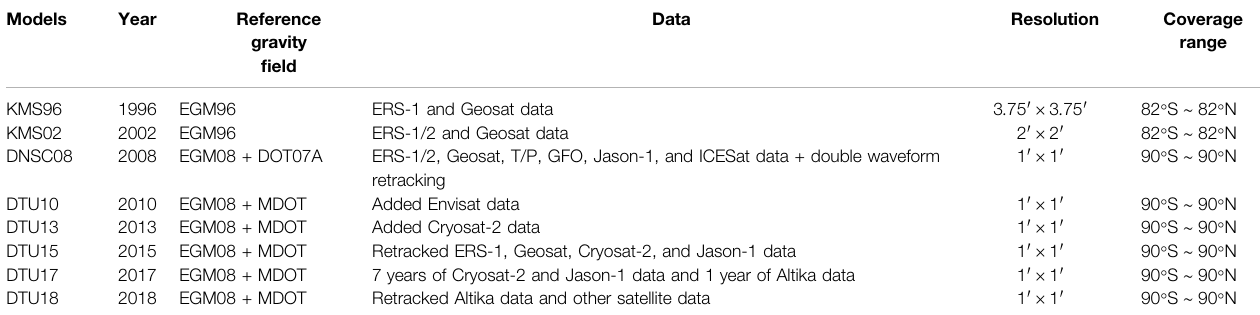
TABLE 2 | Introduction of partial DTU series global marine gravity fi eld models. Models